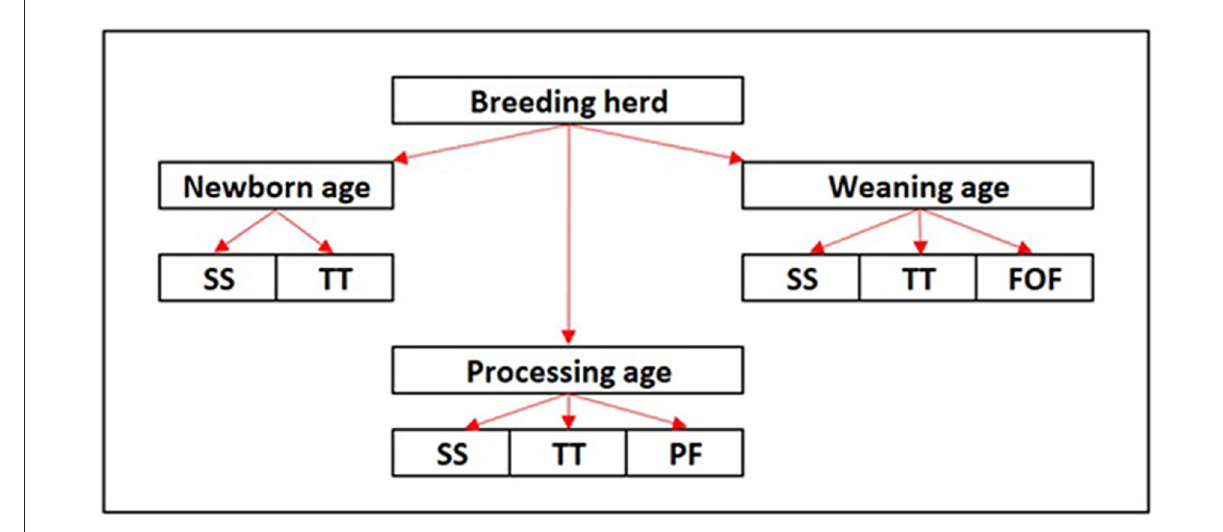
FIGURE1 Diagram of the study design. SS, serum sample; TT, tongue tips; PF, processing fluids; FOF, family oral